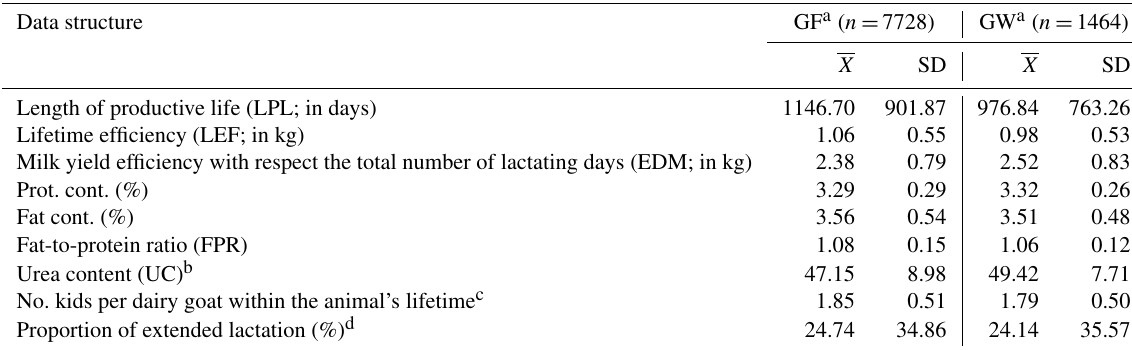
Table 2. Data collected over a dairy goat’s lifetime by breed. Data